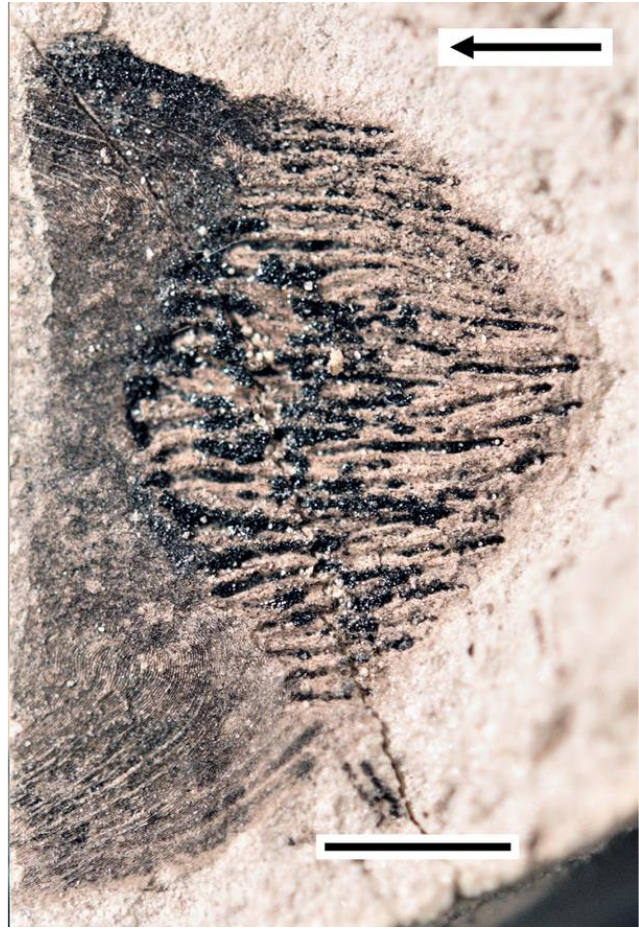
Figure 7. Actinistian scale, specimen MLU Sei.2010.63 from horizon MFL at Fuchsberg Quarry near Seinstedt, Lower Saxony, upper Norian, Upper Triassic. Arrow points anteriad. Scale bar = 3 mm. Photograph, courtesy of John Chorn.